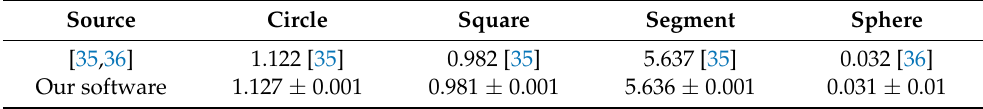
Table 1. Percolation threshold for various geometric objects. Source Circle Square